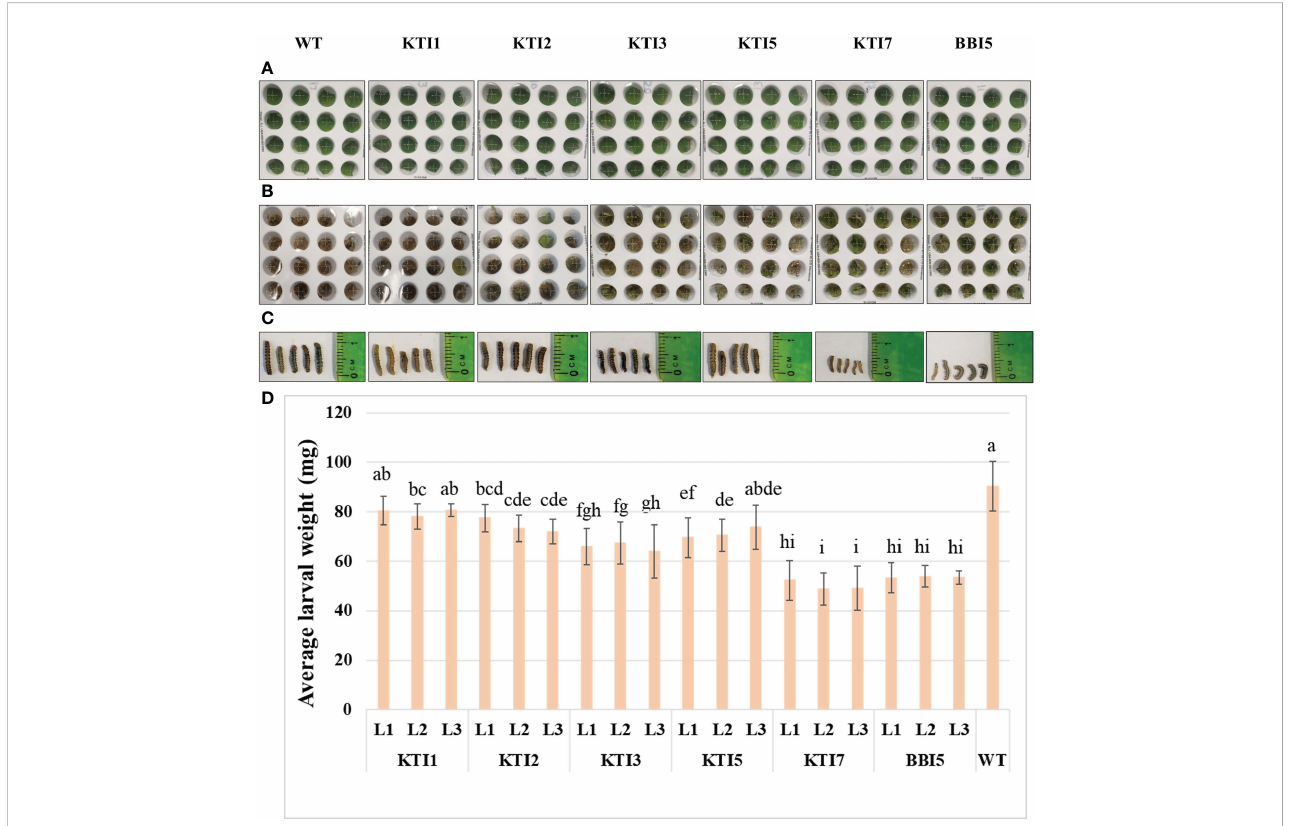
FIGURE 5 Detached leaf-punch bioassay in six-week-old T 3 transgenic soybean (under the control of rbcS-SRS4 promoter) using corn earworm ( Helicoverpa zea ) neonate larvae. (A) Detached leaf-punches from wild-type and transgenic plants. (B) Neonate corn earworm larvae were inoculated in each well and showing after eight days feeding. (C) Representative corn earworm larval size after eight days of feeding. (D) Average larval weight after feeding in WT and transgenic lines (L1, L2, and L3). Bars represent mean values of six biological replicates ± standard error. Bars with different letters are signi fi cantly different at p < 0.05 as tested by one-way analysis of variance followed by a Fisher ’ s least signi fi cant